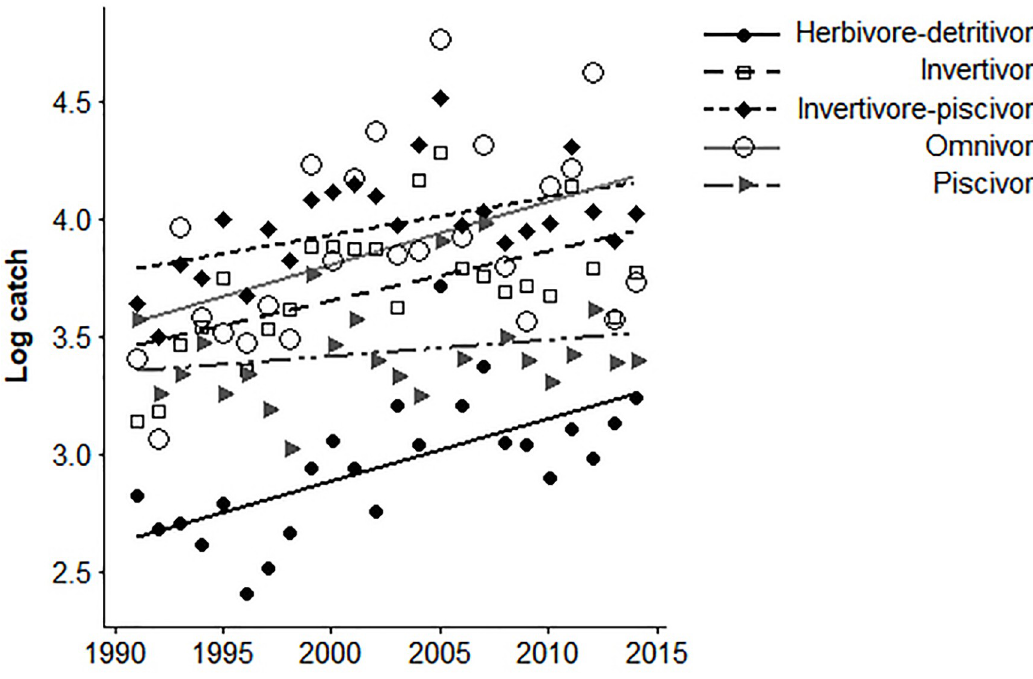
Fig 3. Log-transformed trophic counts by year, for electrofishing collections.